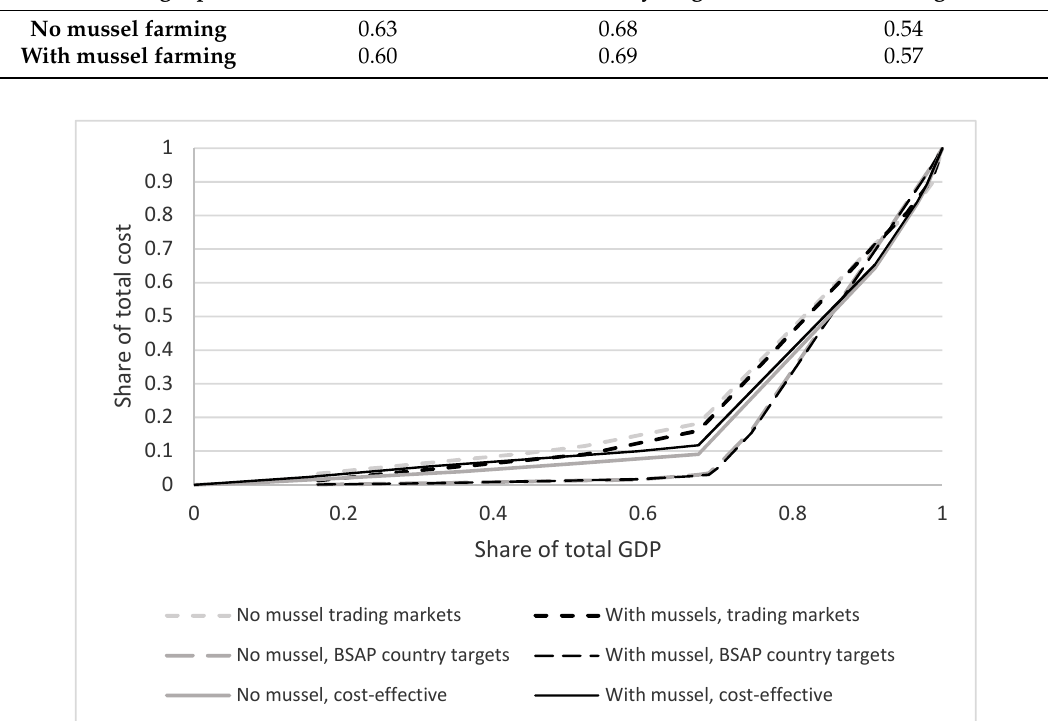
Figure 3. Lorenz curves for abatement costs and GDP under different international policy regimes for reaching BSAP nutrient load targets.